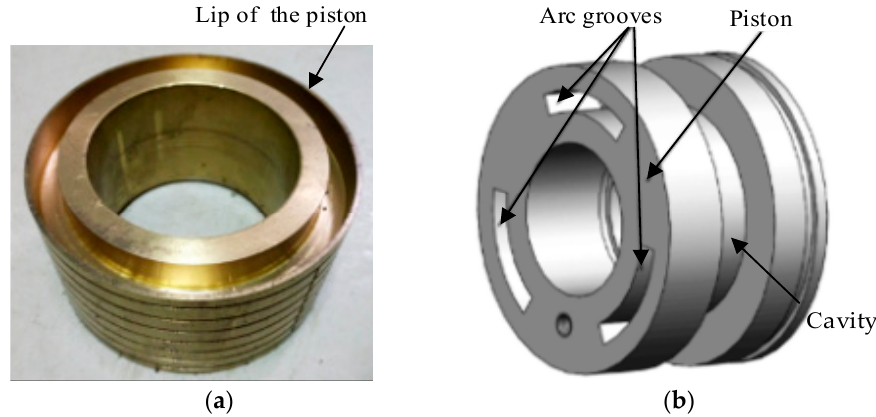
Figure 7. Schematic diagram of the variable gap sealing: ( a ) lip structure; ( b ) cavity structure